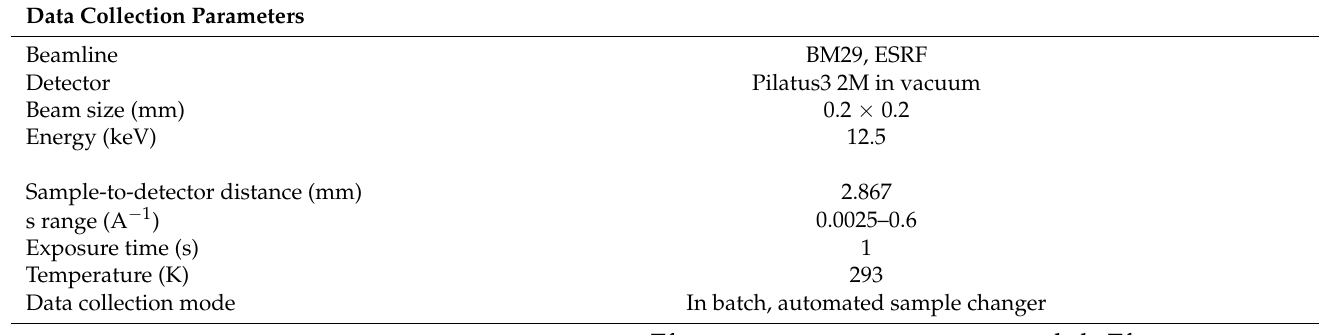
Table 2. Experimental and calculated SAXS